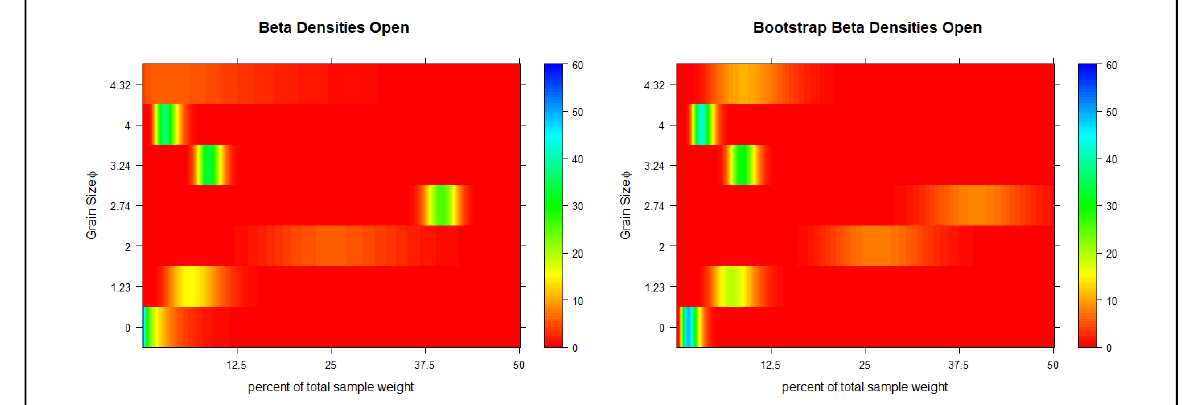
Figure 10. Open test—heat maps of original samples and bootstrap samples.